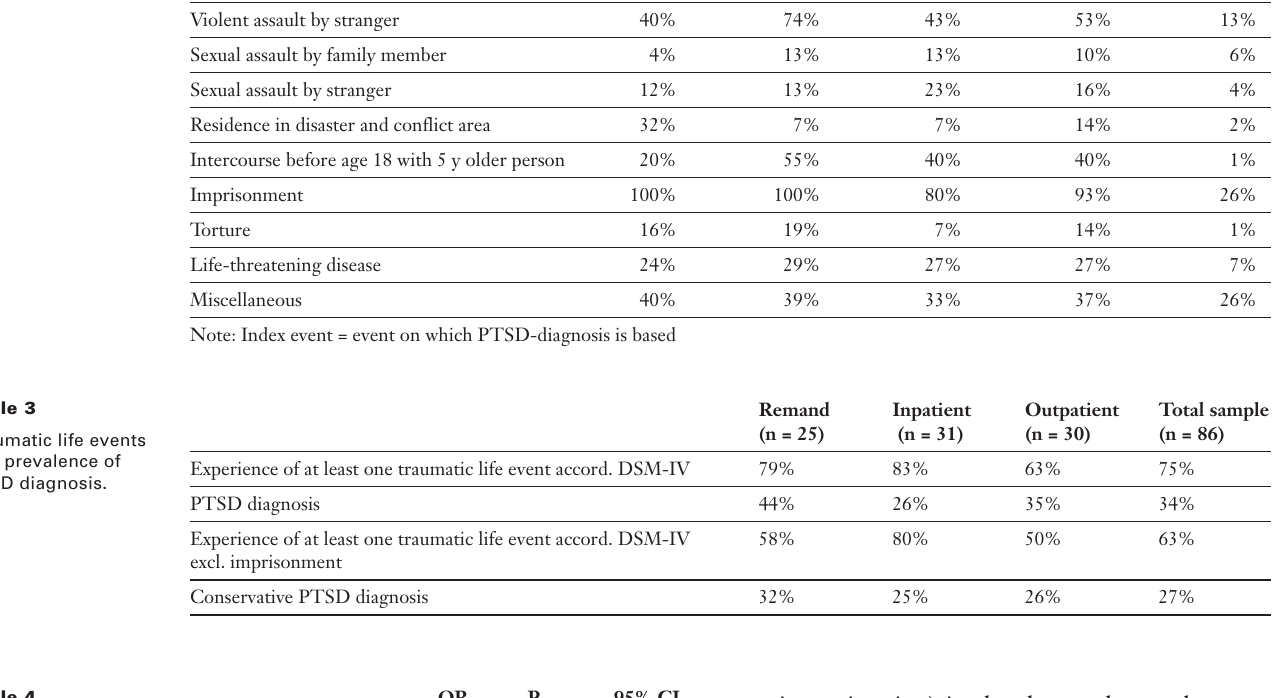
Multivariable logistic regression: the odds of conservative PTSD diagnosis with co- variate adjustment for age, vocational training and judicial